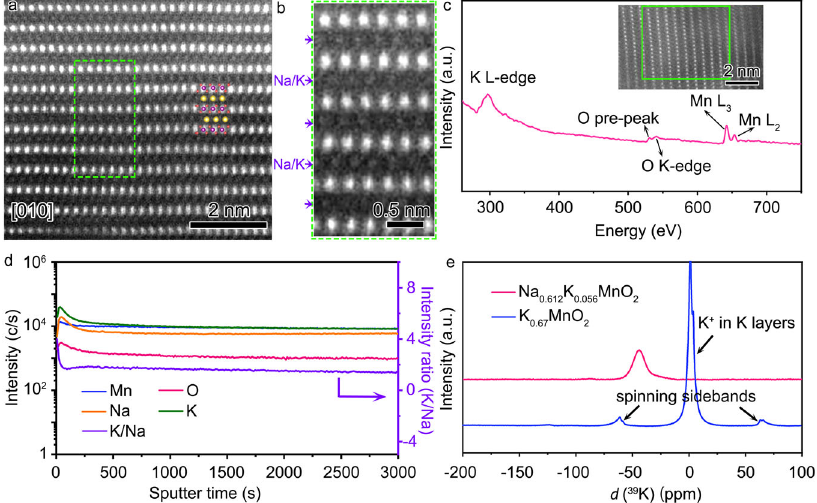
Fig. 2 Atomic structure and elemental distribution of Na 0.612 K 0.056 MnO 2 . a STEM-HAADF image along the direction of [010] of Na 0.612 K 0.056 MnO 2 . b Magni fi ed images of the indicated squares in a . c EELS spectrum of the selected area in the inset image. d SIMS elemental pro fi les at different sputtering times. e Solid-state 39 K NMR spectra of Na 0.612 K 0.056 MnO 2 and K 0.67 MnO